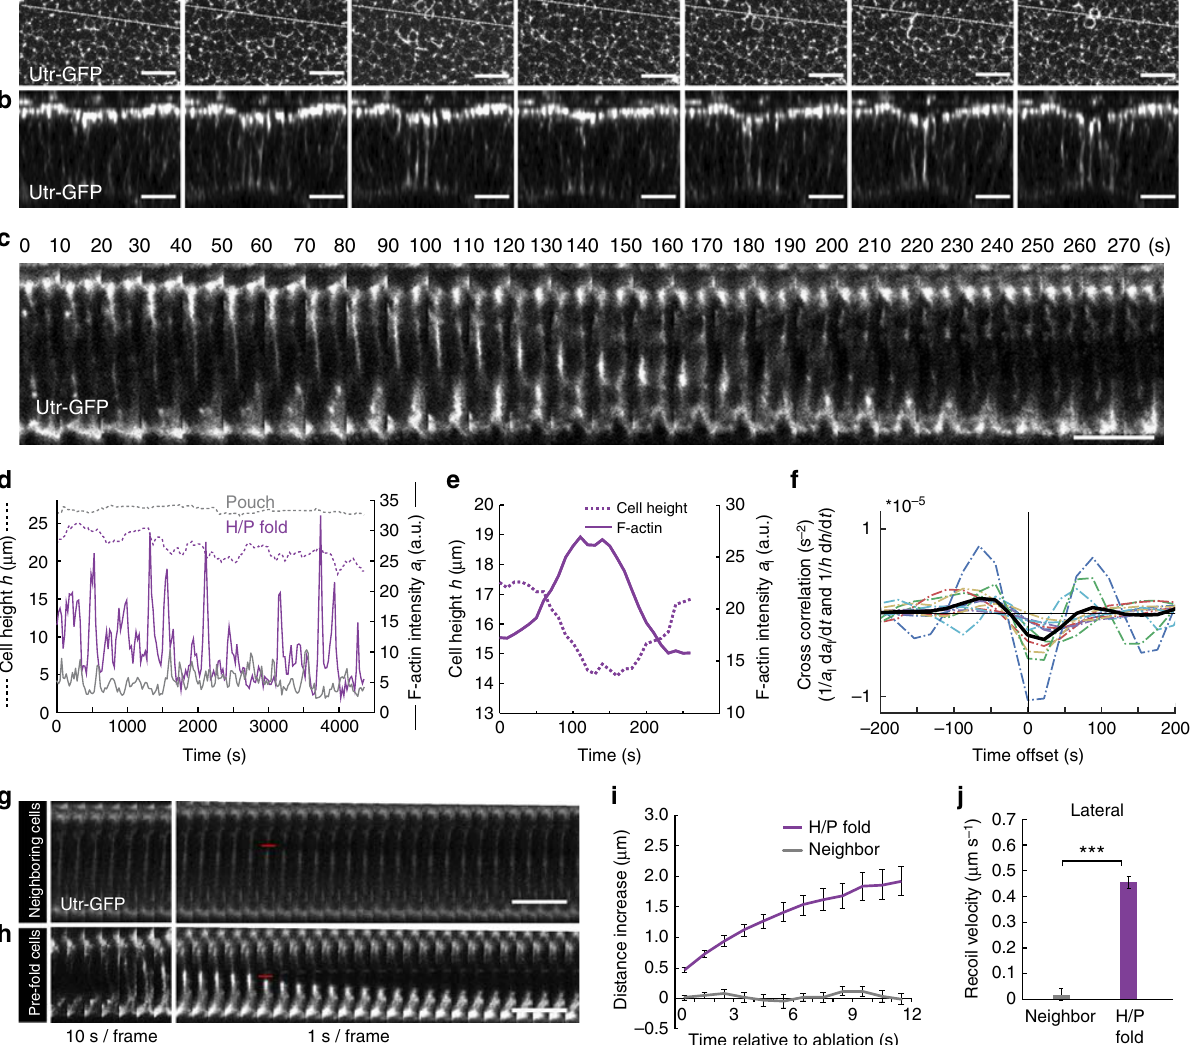
Fig. 6 Increased F-actin and tension at lateral cell interfaces in H/P fold. a , b Middle (13 μ m below apical surface) XY layer ( a ) and cross-sectional images ( b ) of a time-lapse movie of a cultured wing imaginal disc expressing Utr-GFP to label F-actin. The region of the H/P fold is shown. Scale bars are 10 μ m. c Kymogram of cross sections of Utr-GFP-expressing cells in cultured wing imaginal discs showing the dynamics of F-actin in H/P fold cells. Scale bar is 10 μ m. d Lateral F-actin intensity a l (full line) and cell height h (dashed line) for a H/P fold cell (magenta) and a neighboring cell (gray) as a function of time. e Close-up view of lateral F-actin intensity a l (full line) and cell height h (dashed line) for a H/P fold cell as a function of time. f Cross correlation function between the relative rate of change of lateral F-actin intensity (1/ a l ) d a l /d t and rate of relative height change (1/ h )d h /d t as a function of time offset as a function of τ ). Dotted lines: correlation for twelve individual fold cross sections; black line: average correlation ( n = 12). The cross correlation is negative for positive time lags and reaches a minimum for a time lag around 22 s. g , h Kymograms of cross sections of Utr-GFP- expressing neighboring cells ( g ) or H/P fold cells ( h ) before and after ablation of a lateral cell interface. Red lines indicate the time and position of the ablation. Scale bar is 10 μ m. i Increase of the width of the ablated region along the apical-basal axis upon laser cutting of lateral cell interfaces of H/P fold cells and neighboring cells as a function of time after ablation. Mean and s.e.m. are shown ( n = 15 cuts). j Average recoil velocity within 1 s of ablation of lateral cell interfaces of H/P fold cells and neighboring cells. Mean and s.e.m. are shown ( n = 15 cuts) (*** p < 0.001, Student ’ s t